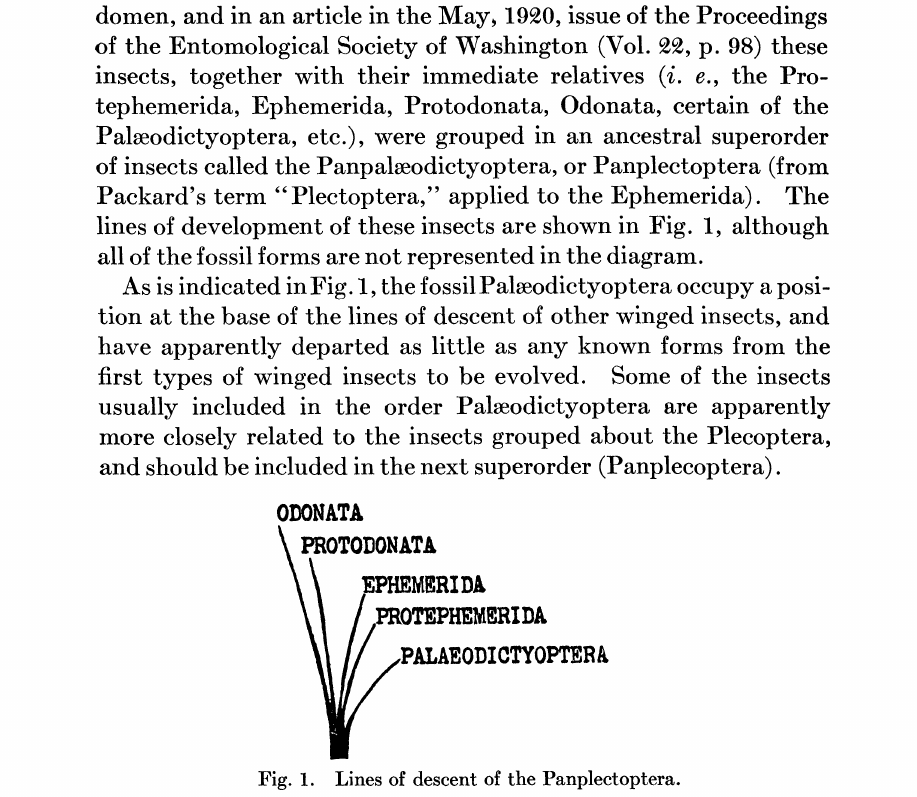
Fig. 1. Lines of descent of the